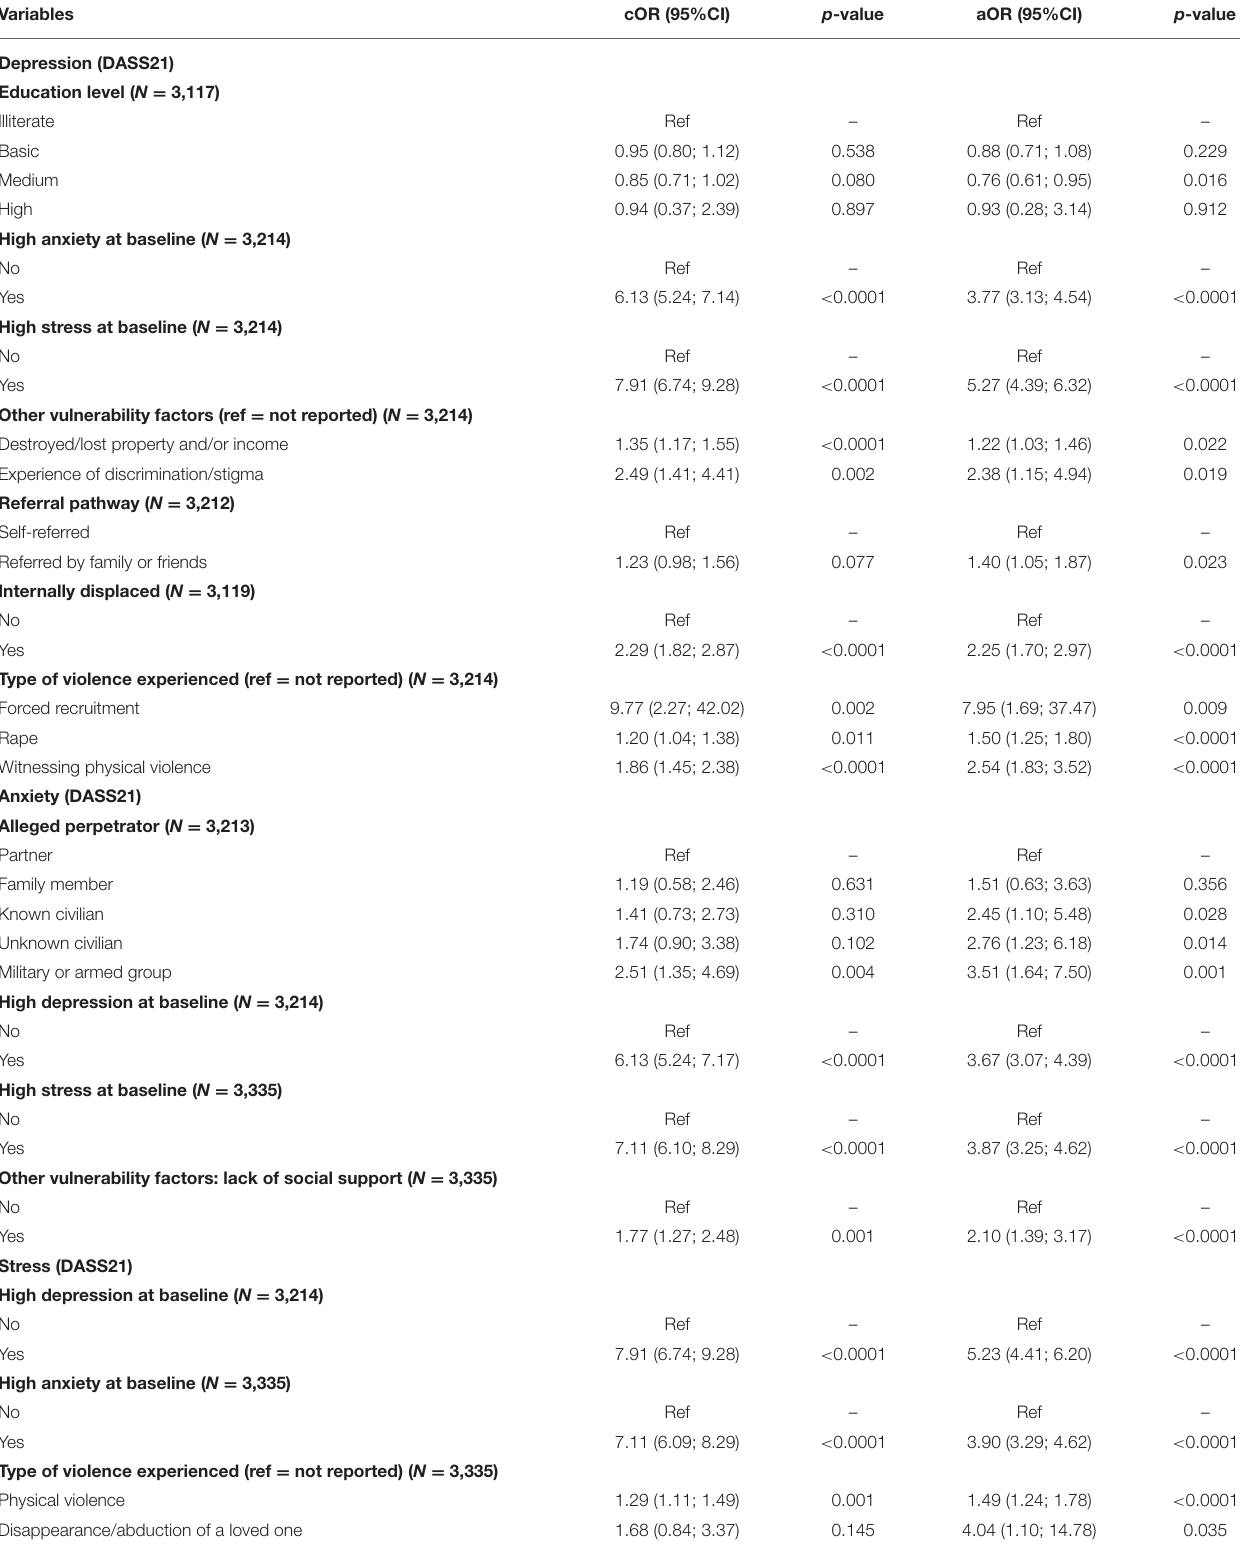
TABLE 4 | Factors associated with high distress and low functioning at baseline.